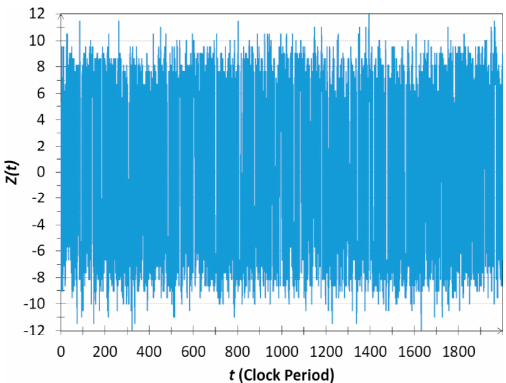
Figure 6. Computer simulation of the N = 32 noise-bit universe in the asymmetric INBL scheme over 2000 clock periods. The time function U ( t ) of the universe, which represents the superposition of all integer numbers from 0 to 4,294,967,295, is plotted in a logarithmically distorted way, defined by (cid:12)(cid:105) (cid:104) (cid:12) (cid:12) (cid:12) (cid:12) 32 ( ) sign Z ( t ) = sign [ U ( t )] log 2 32 (cid:12) U ( t ) , for better visibility of small and large variations.